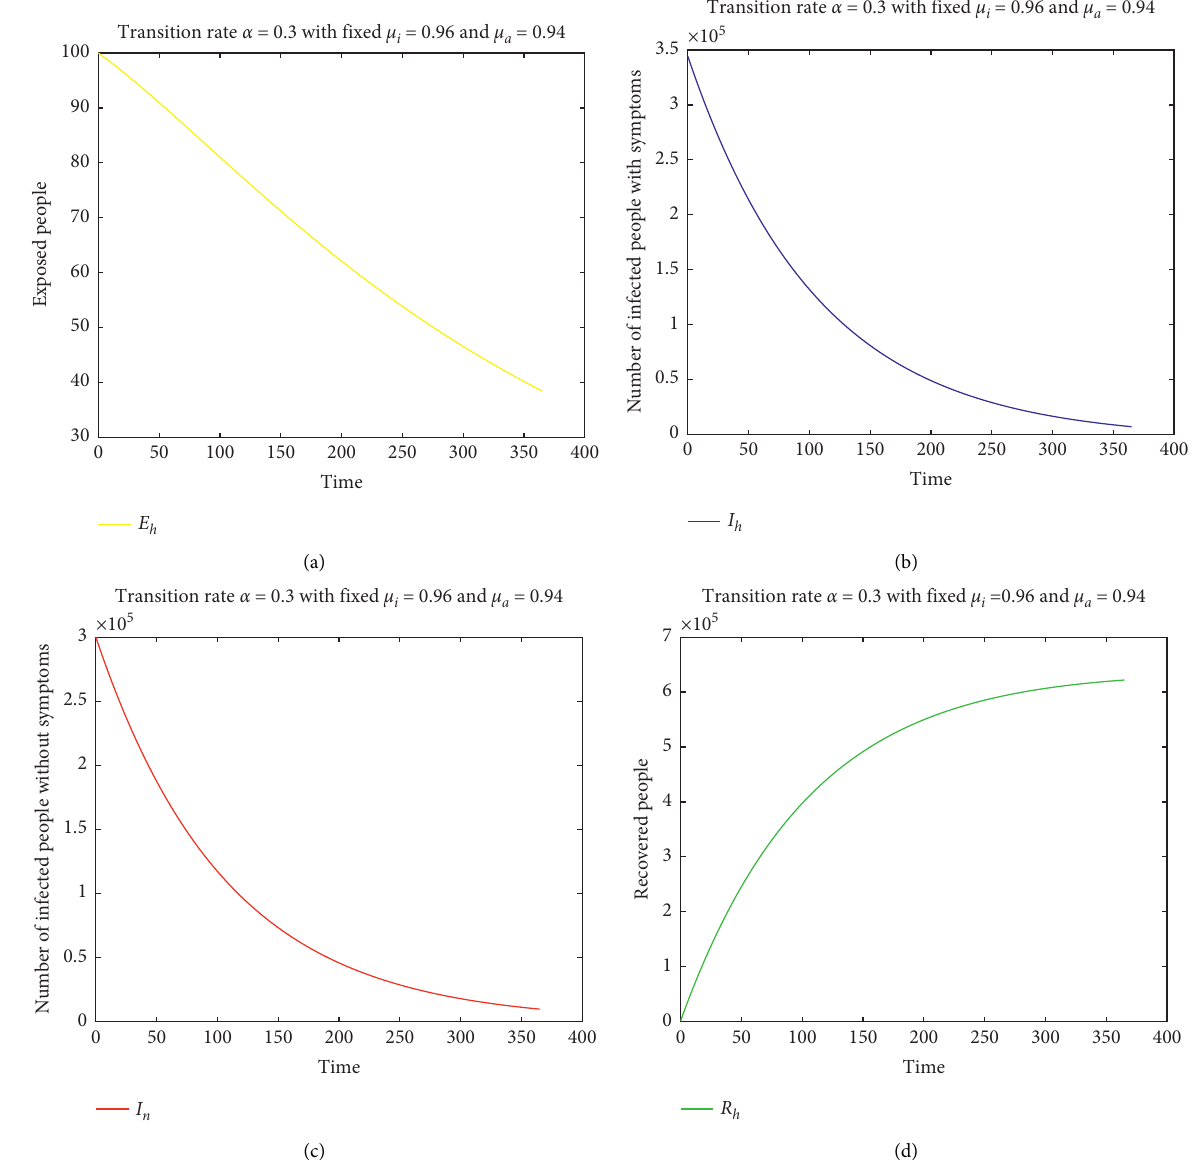
Figure 9: Outbreak dynamics with an infection rate of the virus to the exposed individuals at the infected environment α � 0 . 3: (a) exposed; (b) Infected people with symptoms; (c) infected people without symptoms; (d) recovered